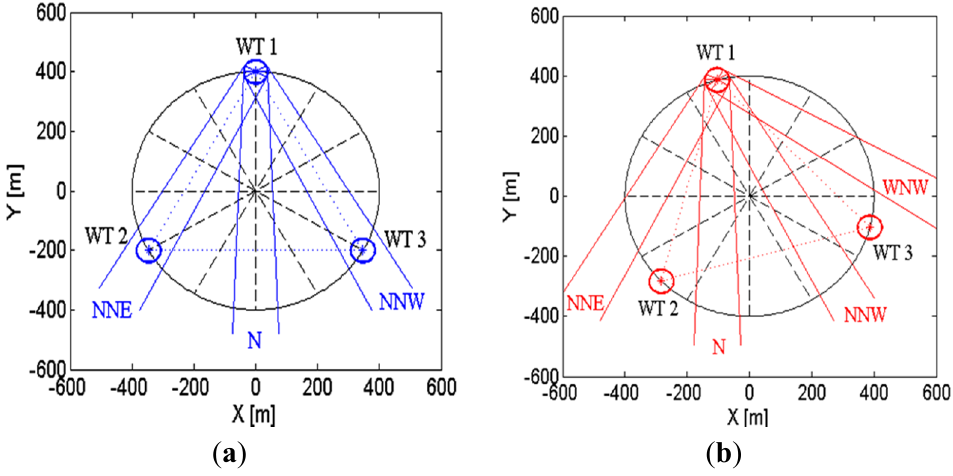
Figure 2. Wake zone developments of WT 1 along certain wind directions, in: ( a ) Layout 1; ( b ) Layout